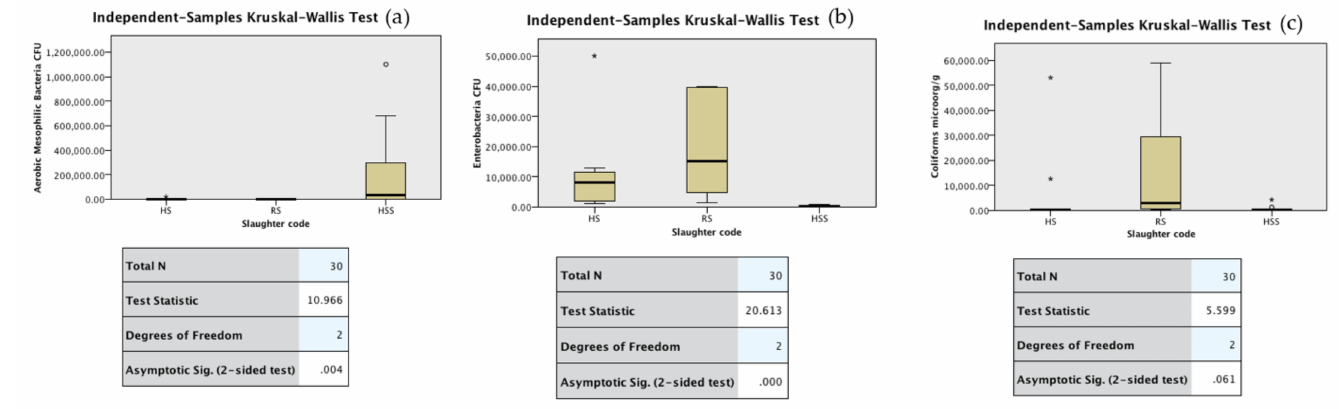
Figure 1. Box and whisker plots for aerobic mesophilic bacteria ( a ), total enterobacteria ( b ), and total coliforms counts ( c ) comparing halal slaughter (HS), halal stunning slaughter (HSS), and regular slaughter (RS). In the boxplot, the thicker line in the middle is the median value. The top and bottom box lines show the first and third quartiles. The whiskers show the maximum and minimum values, except for the outliers (circles) and extremes